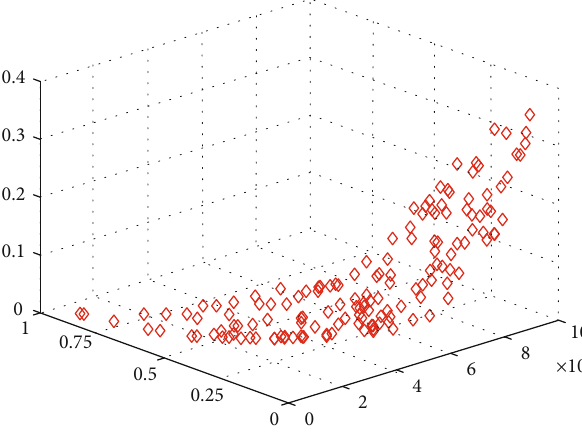
Figure 13: Paretooptimal fronts obtained by